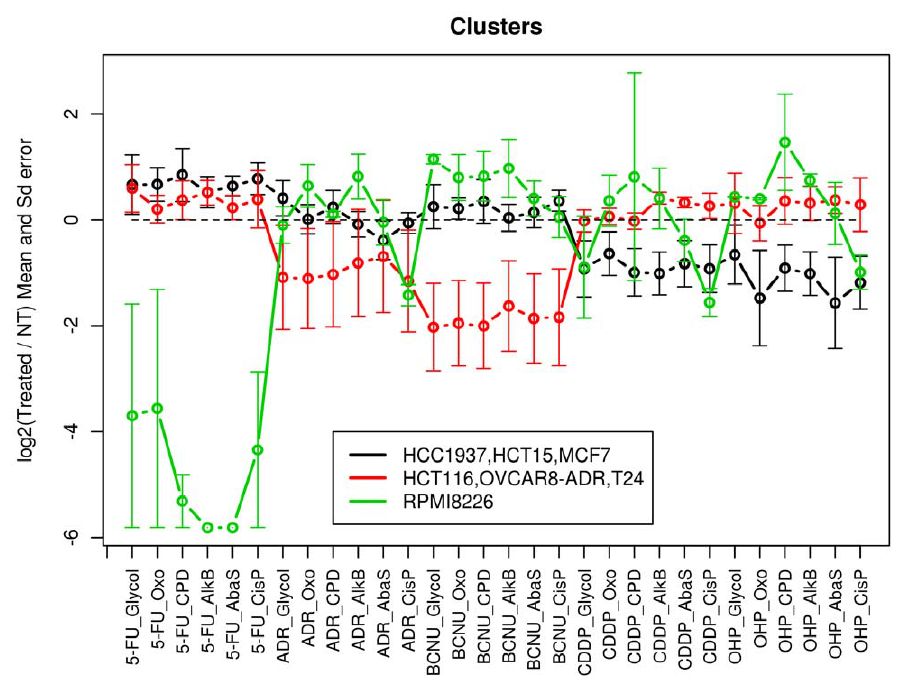
Figure 3. Characteristics of the 3 cell line clusters identified. Means and standard errors of the three identified classes of cell line responses across the five treatments and the six lesion types were calculated using the log2(T/NT) data (black line: HCC1937, HCT-15, MCF7; red line: HCT-116, OVCAR-8/ADR, T24; green line: RPMI8226).